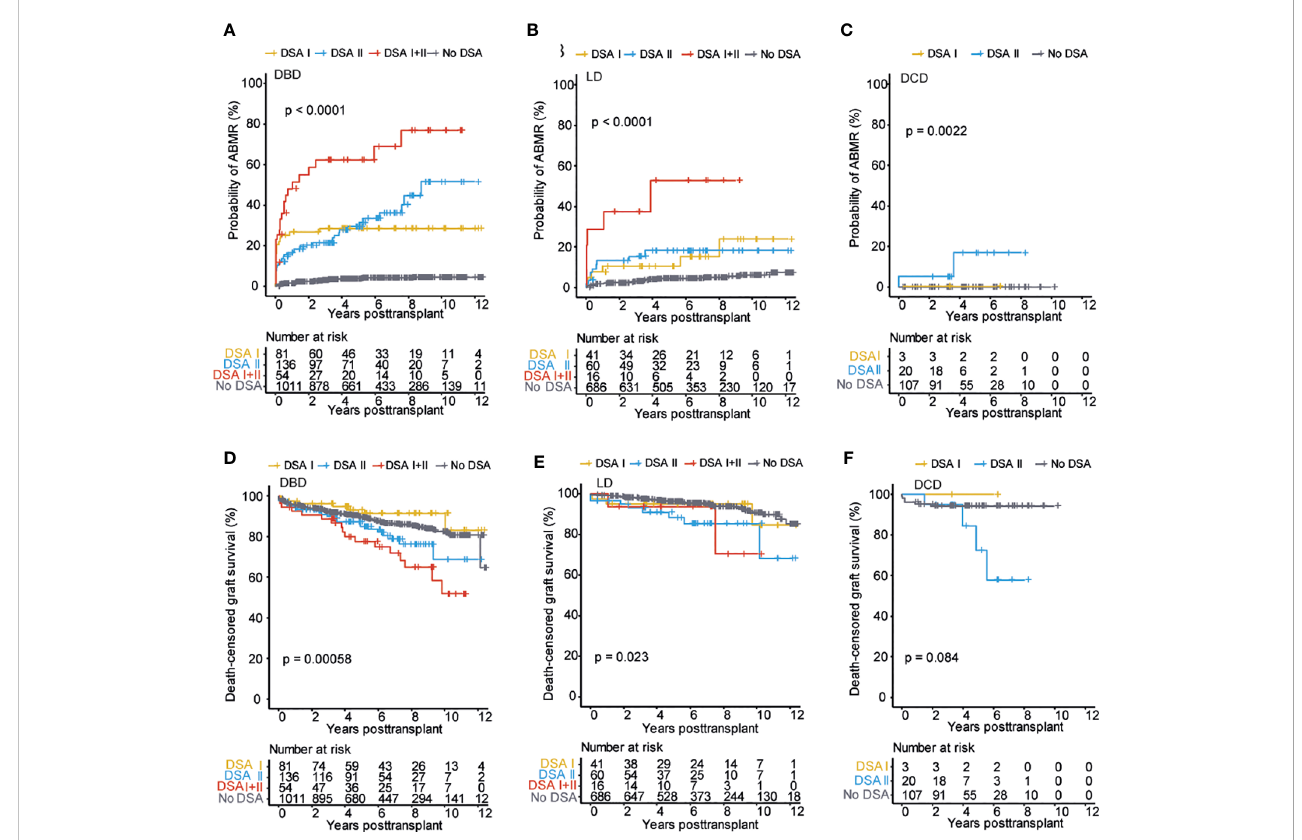
FIGURE 5 Class II directed pre-transplant DSA is associated with worse outcomes regardless of donation type. Cumulative incidence of ABMR in patients who received DBD transplants (A) , LD transplants (B) , and DCD transplants (C) strati fi ed on DSA target HLA Class. Cumulative incidence of death-censored graft survival in patients who received DBD transplants (D) , LD transplants (E) , and DCD transplants (F) strati fi ed on DSA target HLA Class. Log-rank test was used to test p value of the Kaplan-Meier survival curves for all the